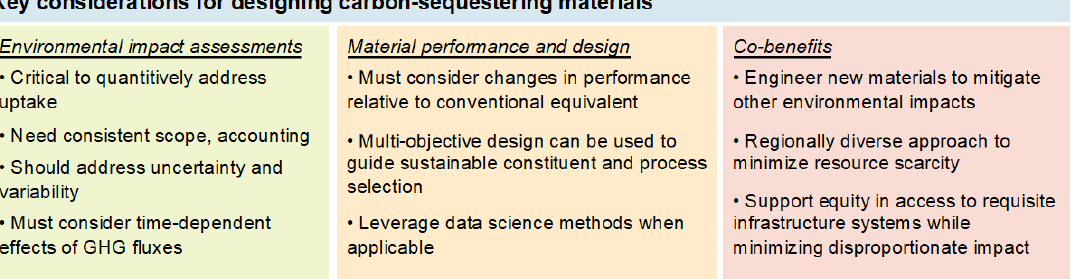
Figure 2. Simplified framework of considerations to be made as CO 2 -uptake materials are